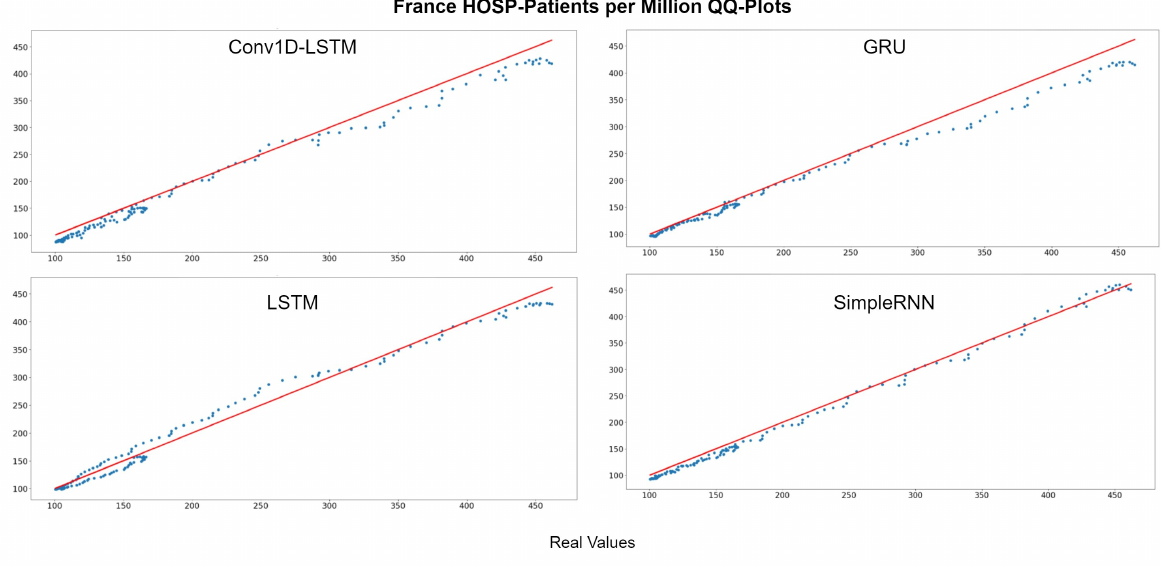
Figure 19. France HOSP-Patients per million QQ-Plot for each